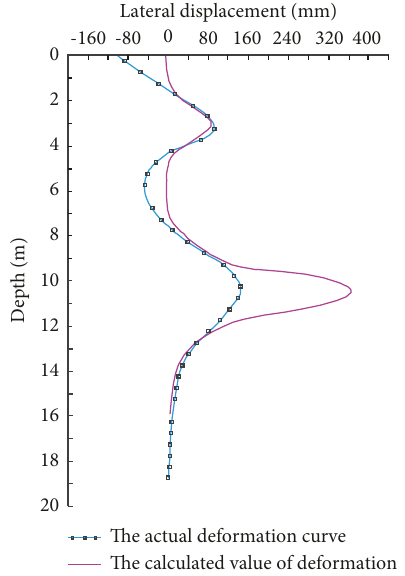
Figure 9: Curve of lateral deformation versus